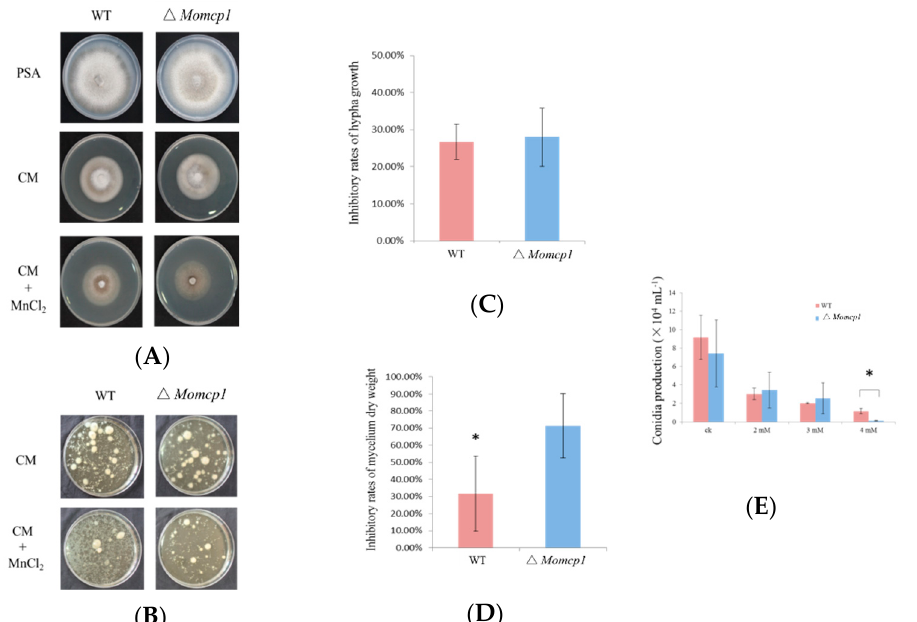
Figure 1. ∆ Momcp1 is sensitive to Mn 2+ . ( A ) The appearances of colonies under different plates. ( B ) The mycelium obtained from liquid CM for two days with or without 2 mM Mn 2+ treatment. ( C ) The inhibitory rates of hypha growth under a 6 mM Mn 2+ treatment. The colony diameter of each strain was measured at seven days after inoculation at CM plates containing 6mM Mn 2+ . ( D ) The inhibitory rates of the mycelium dry weight under a 2 mM Mn 2+ treatment. The dry weight of mycelium of each strain was measured at two days after inoculation into the Mn 2+ containing liquid CM. ( E ) The conidia production. The numbers of conidia were counted at ten days after inoculation on Mn 2+ containing OMA plates. The significant difference was determined by a t -test; *, p < 0.05.